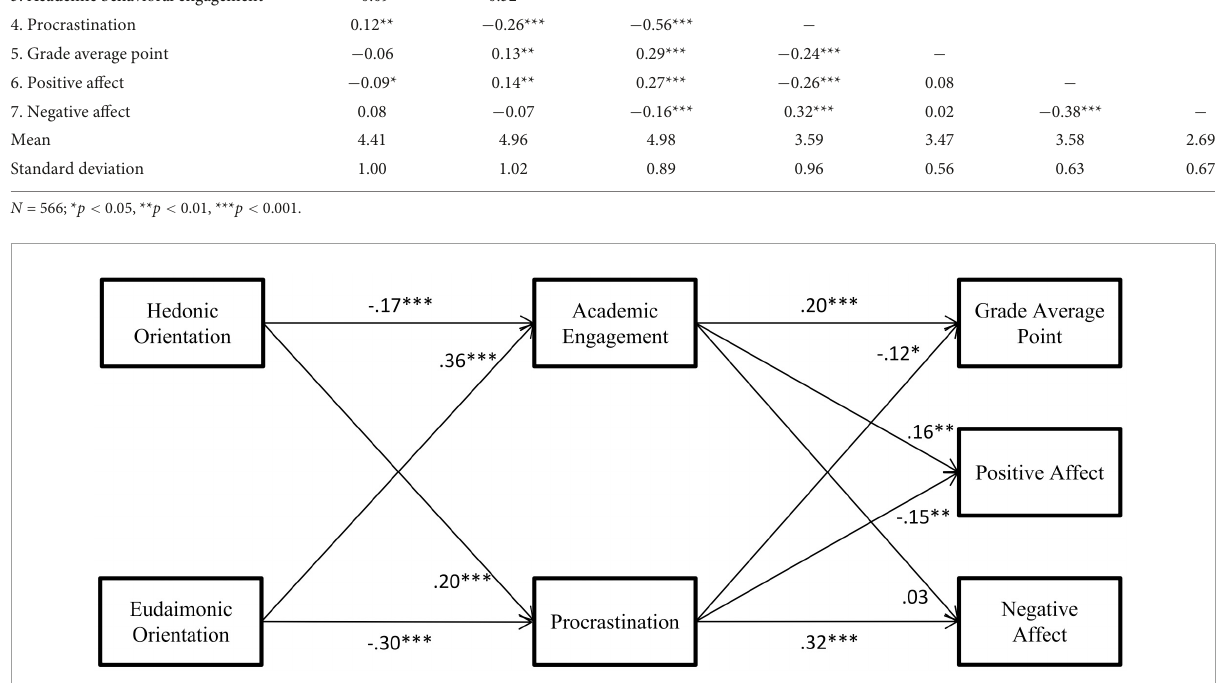
FIGURE1 Indirect effects of happiness orientation on well-being outcomes through academic behavioral engagement and procrastination. The numbers represent standardized estimated coefficients. Participants’ gender and age were allowed to predict academic behavioral engagement, procrastination, grade average point, positive affect, and negative affect while omitted in the figure. The direct effects of happiness orientation (which were all non-significant) were also omitted in the figure. ∗ p < 0.05, ∗∗ p < 0.01, ∗∗∗ p <